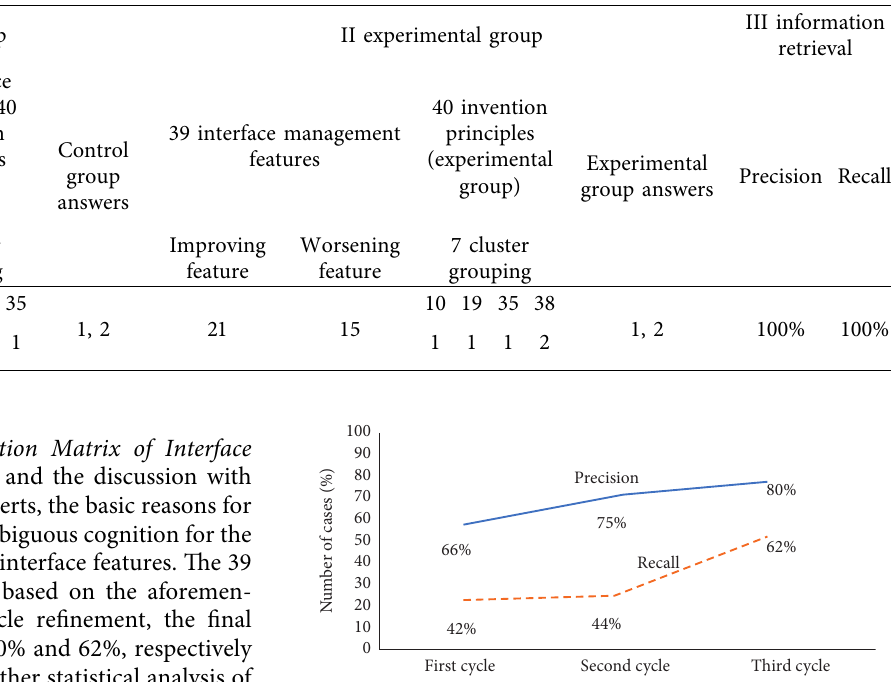
Figure 3: Statistics of the test cases. Table 7: Comparison and evaluation of the experimental group and control group.